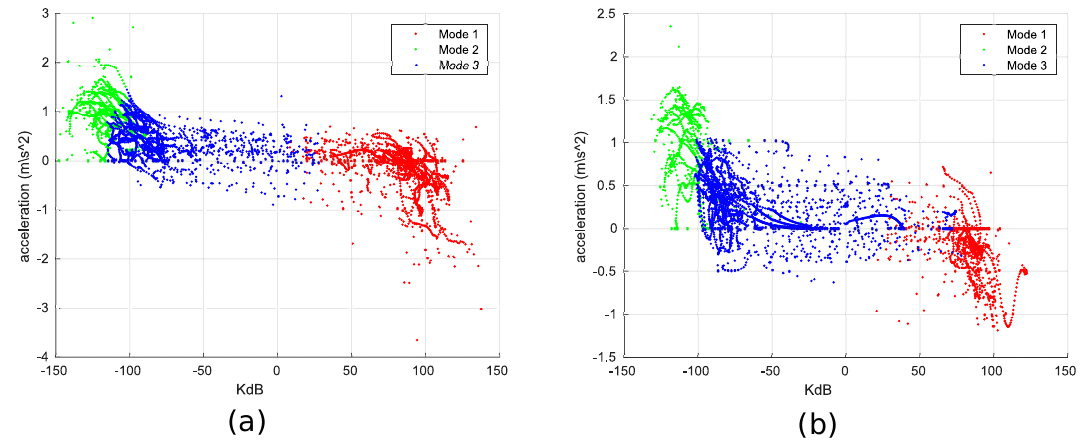
Figure 8. Mode segmentation result (optimal number of sub-models) of the car-following task in the acceleration-KdB space, where a unique color represents a unique mode (sub-model) with it’s own distinctive motion-control characteristics: ( a ) three-mode model identified for driver A; ( b ) three-mode model identified for driver